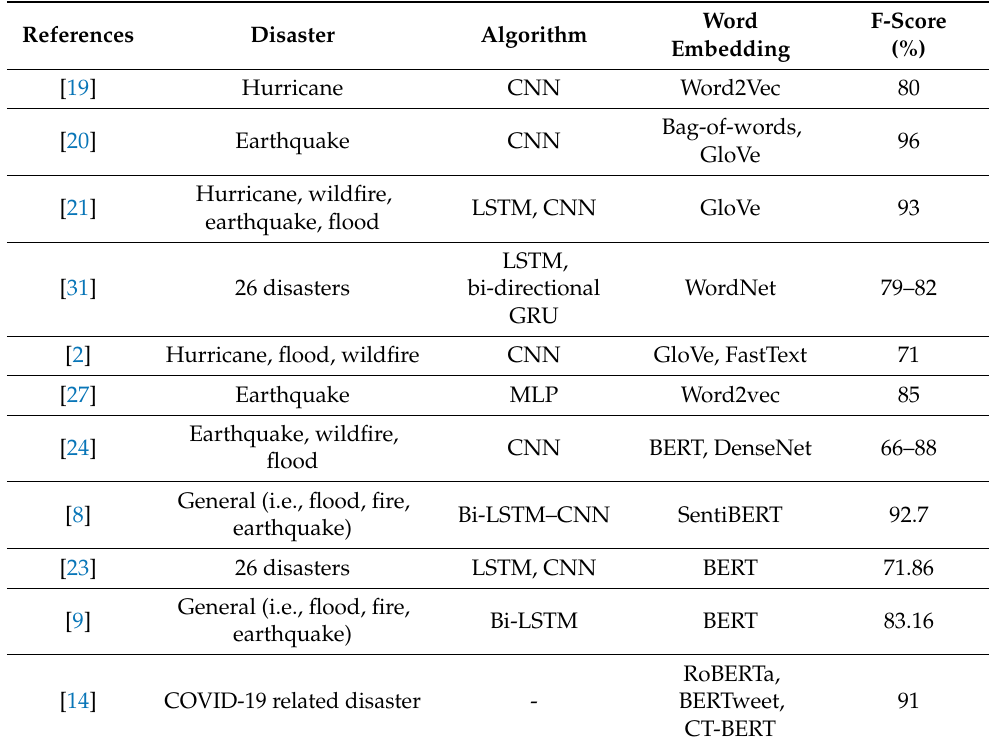
Table 1. Summary of deep learning studies in detecting tweets related to